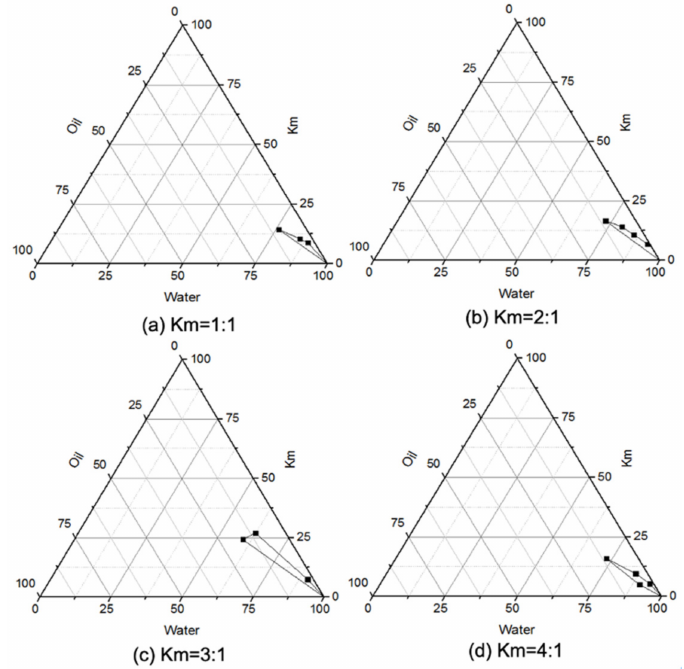
Figure 3. Pseudoternary phase diagrams consisting of Capryol 90, RH 40 and Transcutol®P, with Km values of ( a ) 1:1, ( b ) 2:1, ( c ) 3:1, ( d ) 4:1.